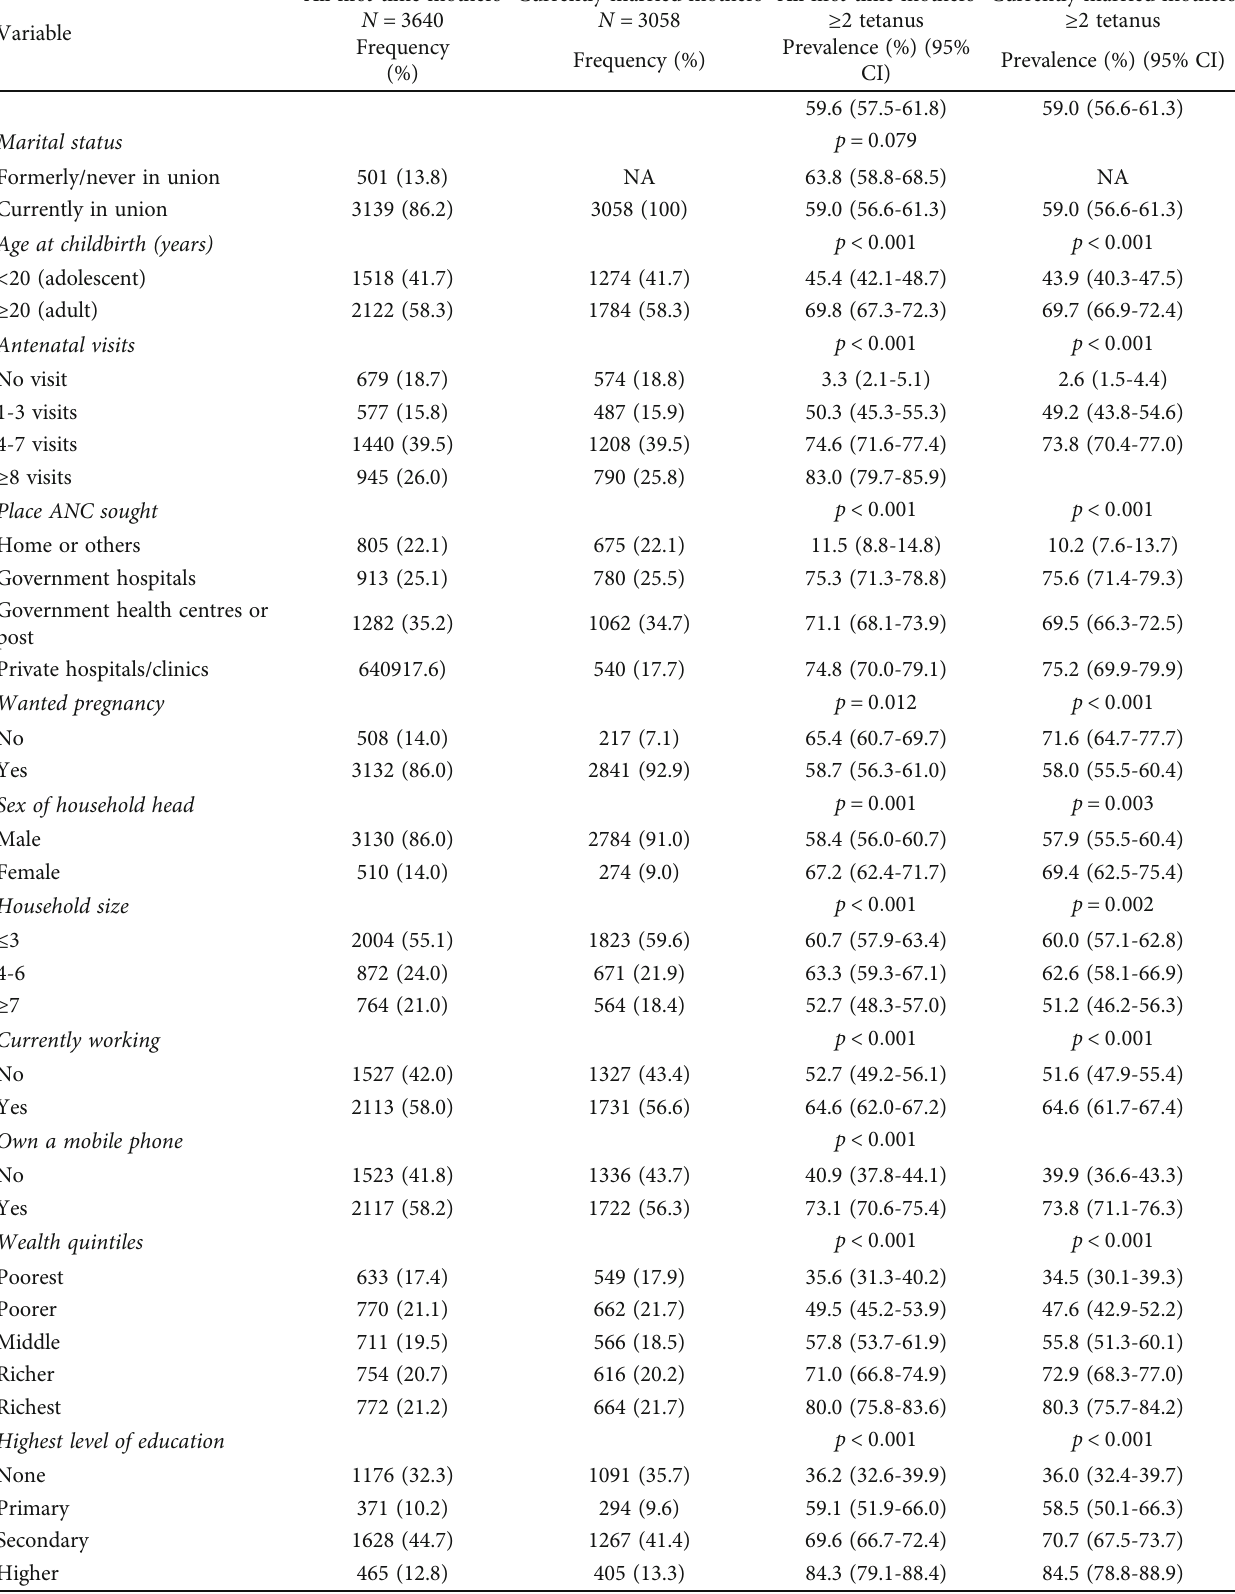
Table 1: Descriptive characteristics of fi rst-time mothers who took at least two doses of TTCV, NDHS